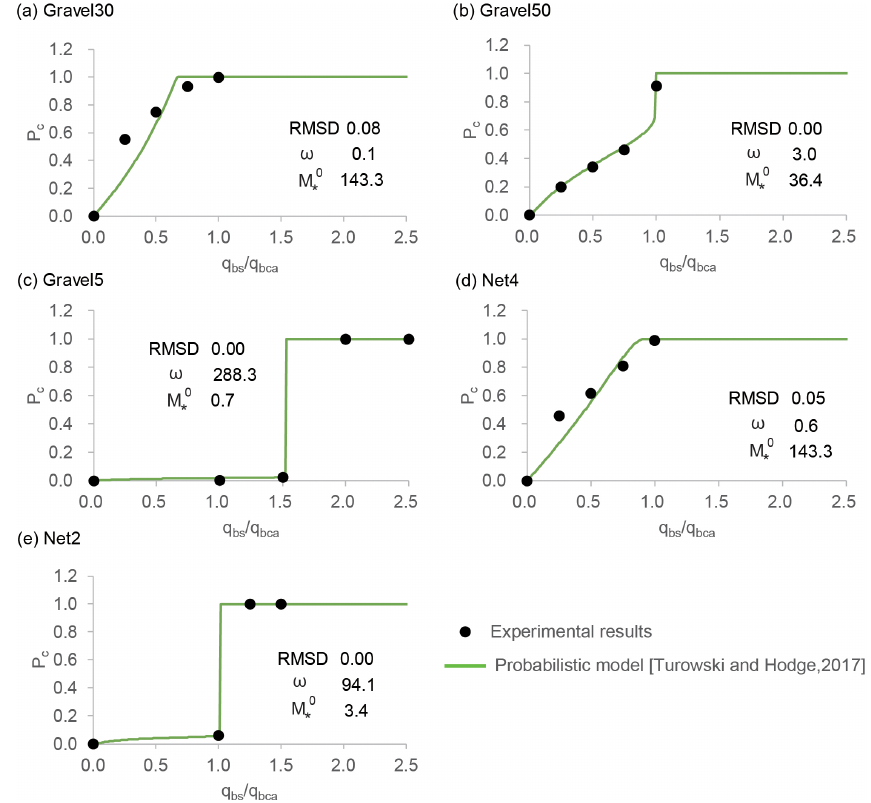
Figure 12. Comparison of our experimental results with the probabilistic model proposed by Turowski and Hodge